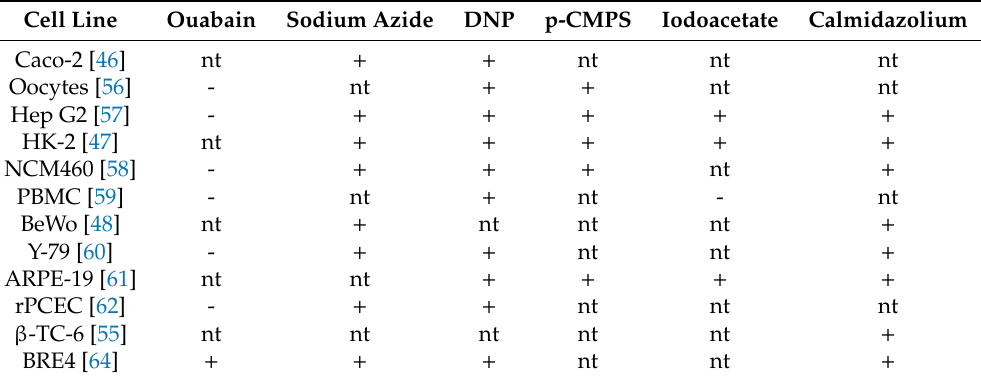
Table 3. E ff ects of di ff erent inhibitory compounds on riboflavin uptake.